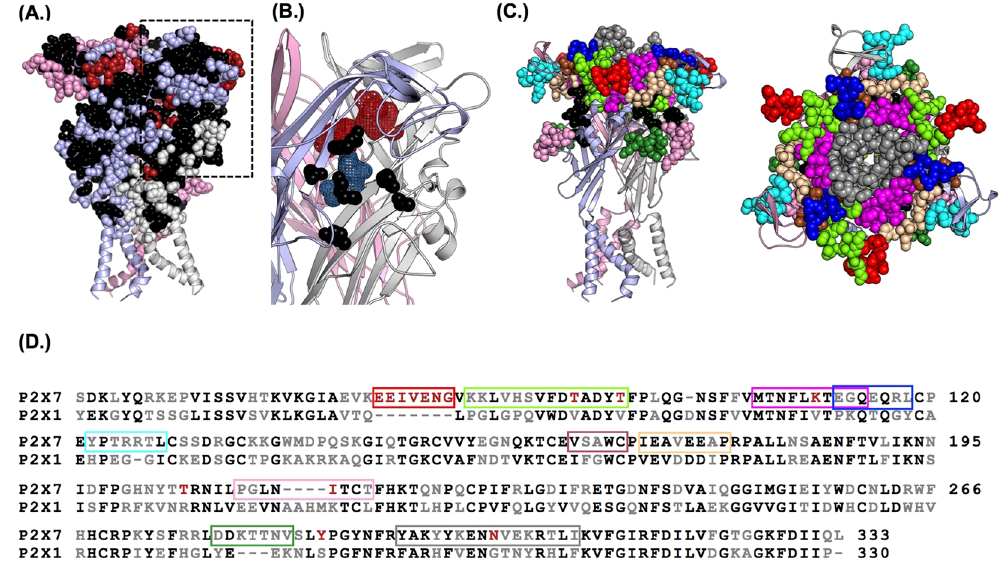
Figure 1. Location of chimeras and mutants to investigate potential orthosteric and allosteric binding sites for AZ10606120. ( A ) Homology model of the hP2X7R with the three subunits cartoon representations shown in grey, light purple and light pink. Conserved residues are shown as black spheres, residues unique to the P2X7R are shown as red spheres and variant residues between P2X7 and the other subunits are shown as spheres the colour of the subunit they are in. ( B ) FT site based predictions of orthosteric (teal) and allosteric (raspberry) binding pockets in the P2X7 receptor, conserved residues involved in ATP binding at one subunit interface are shown in black. Panel shows the region highlighted by dotted box in ( A ). ( C ) Homology model of the P2X7 receptor (from the side, left and from the top of the receptor, right) showing the region 73–79 (in red) and regions replaced by corresponding region of the P2X1 receptor for the chimeras (colour coding see ( D )). Black spheres correspond to the residues that are conserved throughout P2X receptors that co-ordinate the binding of ATP. ( D ) Amino acid line-up of the extracellular ligand binding region of the human P2X7 and P2X1 receptors. Black residues are conserved in at least one mammalian orthologue of all P2X subunits, red is unique to the P2X7 receptor. Regions of mutation/chimera are shown by coloured